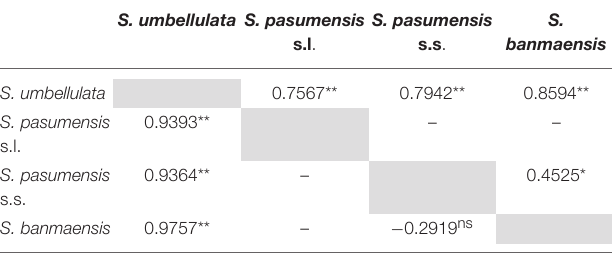
df, degrees of freedom; SS, sum of squares; VC, variance components; PV, percentage of variation; F ST , fixation index; * P < 0.01.